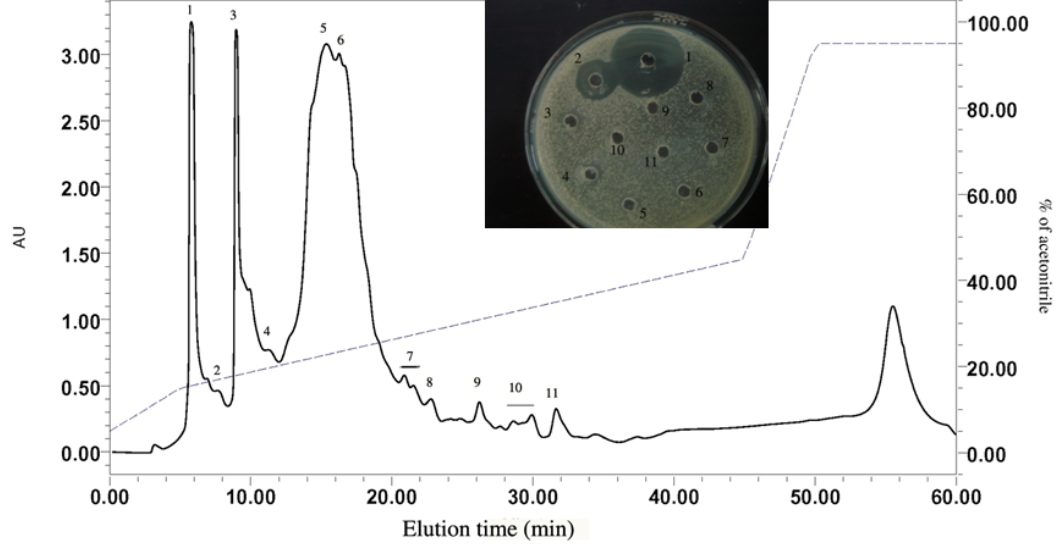
Figure 3. Chromatogram profile and antibacterial activity of HAHp2-3-I analyzed by Source 5RPC ST column. Numbers beside the wells represented the peak numbers in the chromatogram